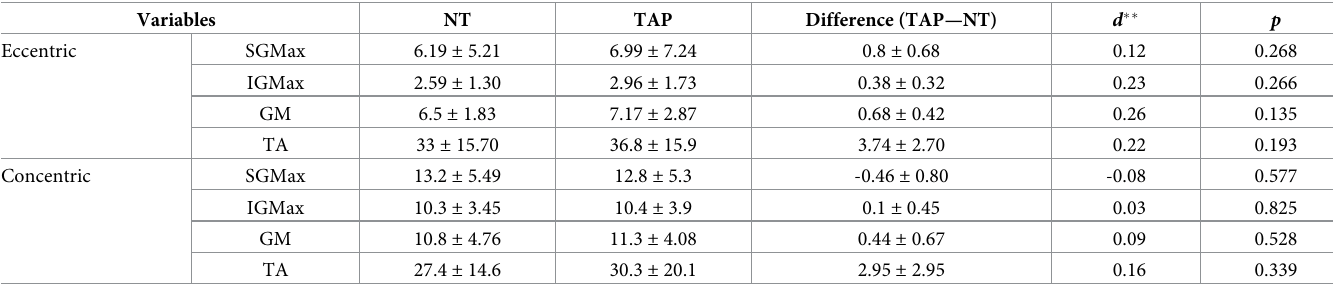
Table 2. Muscle activities between NT and TAP conditions (%MVIC) �